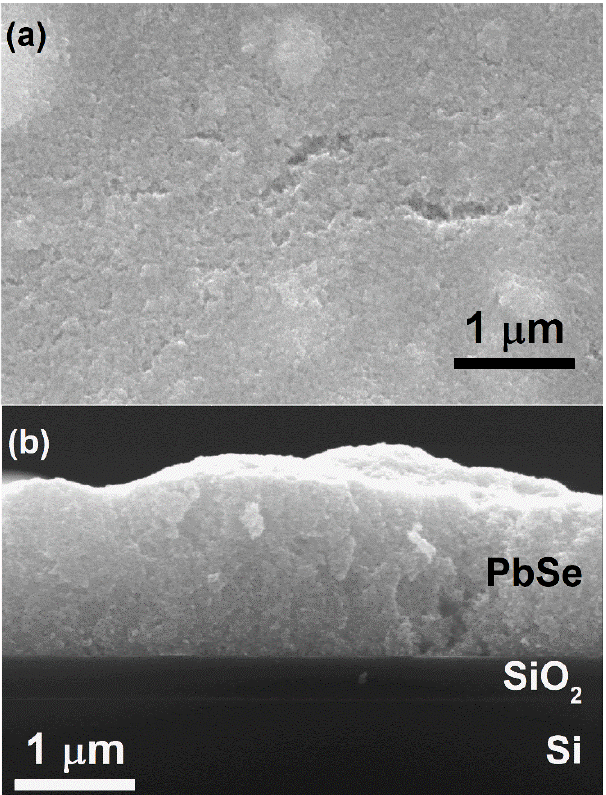
Figure 3. Representative surface ( a ) and cross-sectional ( b ) SEM images of the PbSe QD thin film, fabricated through screen printing followed by rapid heat treatment.